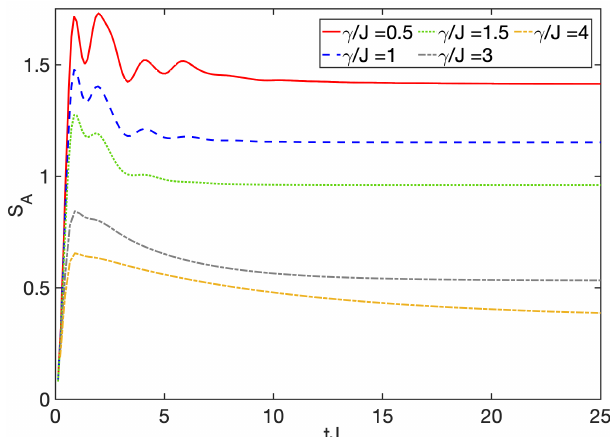
Figure 2: The dynamics of the entanglement entropy S measurement rate. Different curves have different γ in the unit of J . Here, U = J = 6, and the number of bosons N and the number of sites N s = size L A